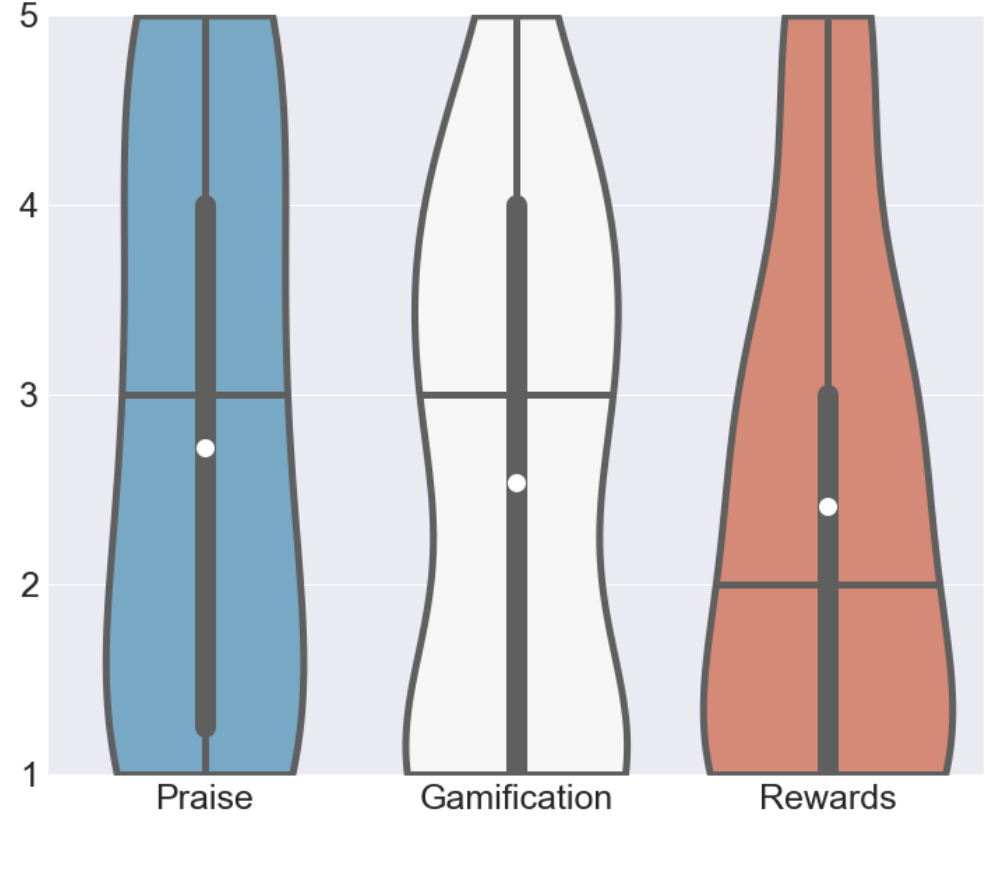
Figure 7. Scores of features in the group of Social interaction. The white dot denotes the mean value, the horizontal black bar denotes the median value, the thick black bar denotes the interquartile range and the thin black bar denotes the 95% confidence interval.